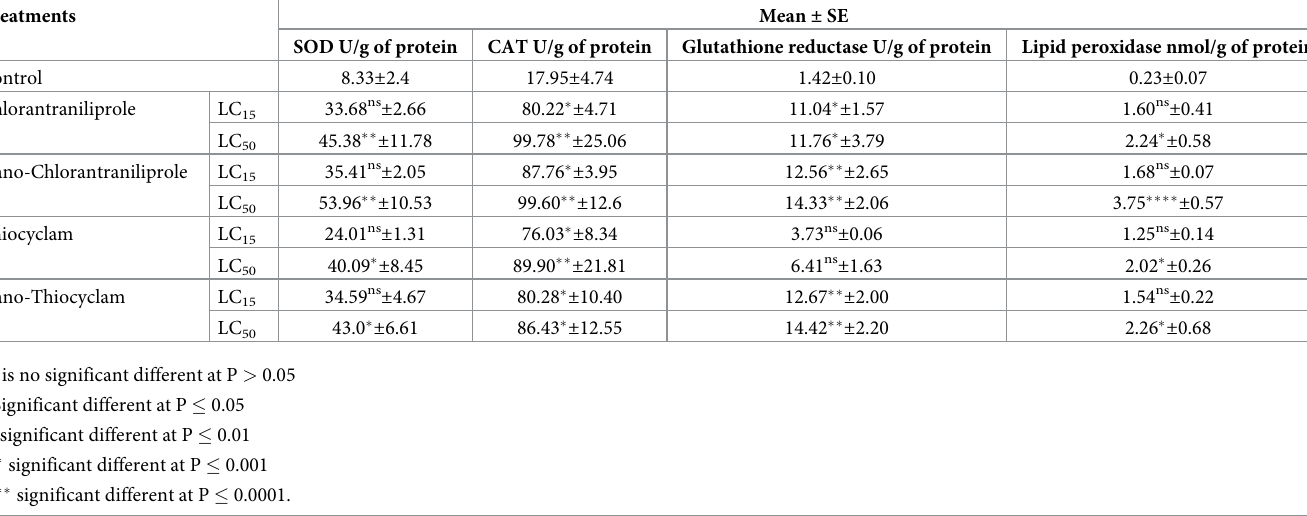
Table 5. Mean ( ± SE) of oxidative stress enzymes (SOD, CAT, glutathione reductase, and lipid peroxidase) activities of A . ipsilon after exposure of 2 nd instar larvae to LC 15 and LC 50 values of chlorantraniliprole, thiocyclam, and their nano-forms.